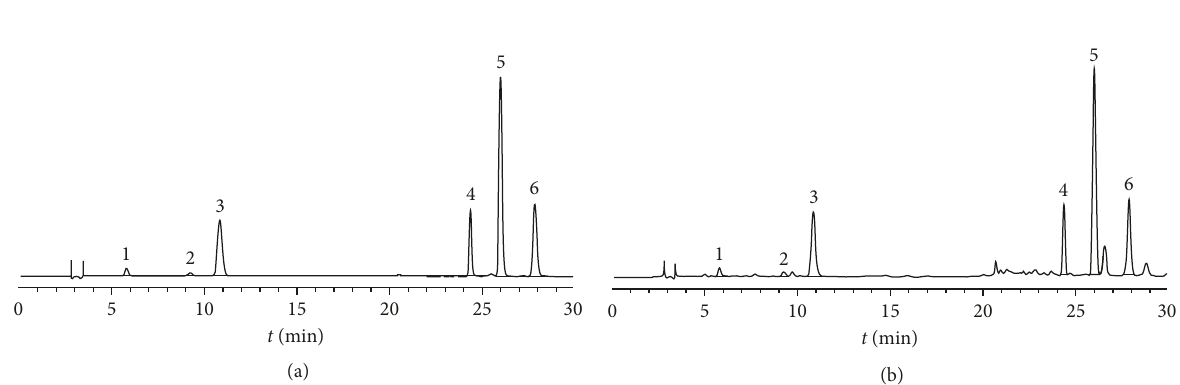
Figure 2: HPLC chromatograms of the (a) standard mix stock solution and (b) sample (D10 roots).1, NCA; 2, CCA; 3, CA; 4, ICB; 5, ICA; 6,